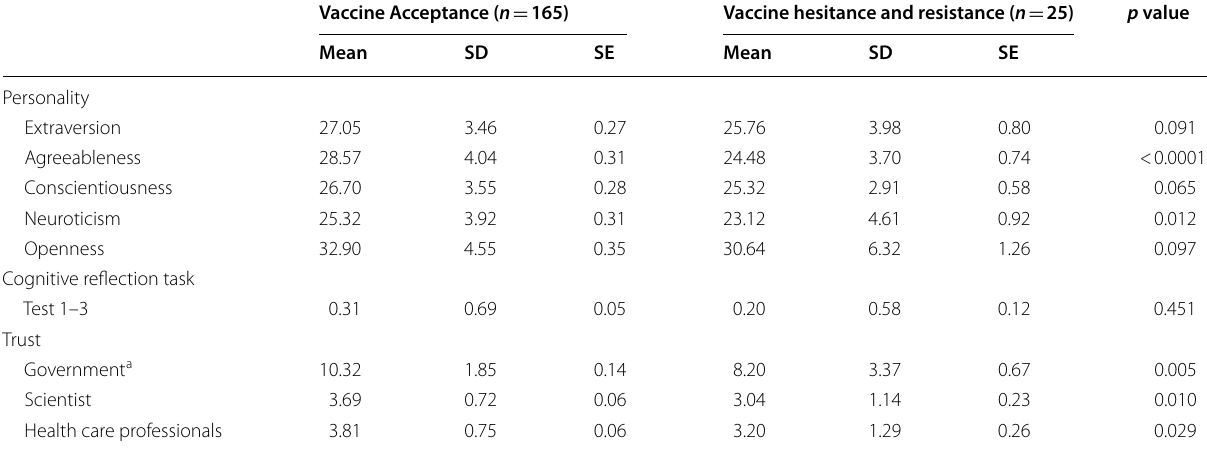
Table 2 Physiological indicators amongst vaccine acceptance, vaccine hesitancy, and vaccine resistance